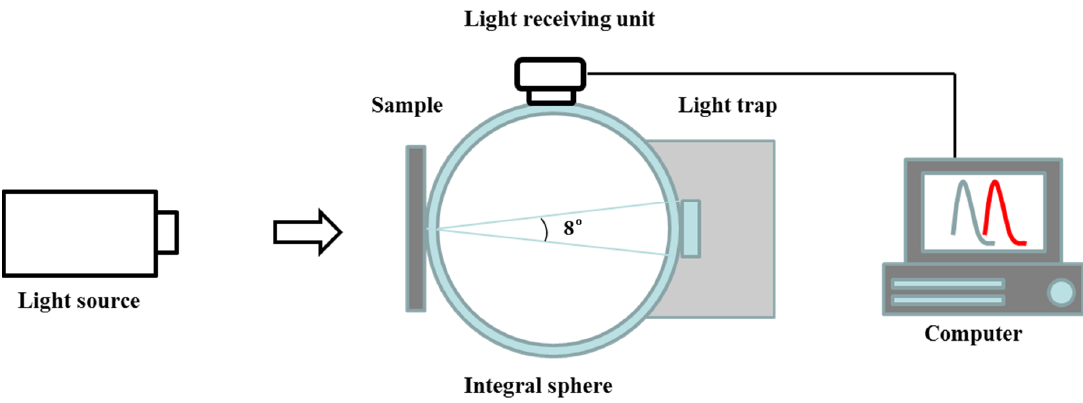
Figure 10. Schematic diagram of the haze meter. The light from the light source first transmits through the sample, then is reflected in the integral sphere, and finally arrives at the light receiving unit.